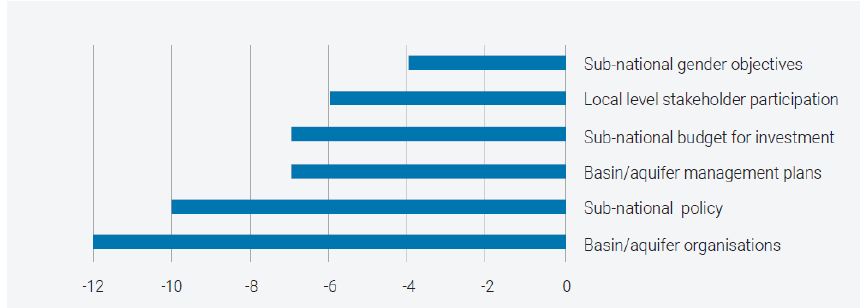
Figure 6. Difference between global average implementation of integrated water resources management (IWRM) at subnational, basin, and local levels, compared to the national-level equivalents [36].